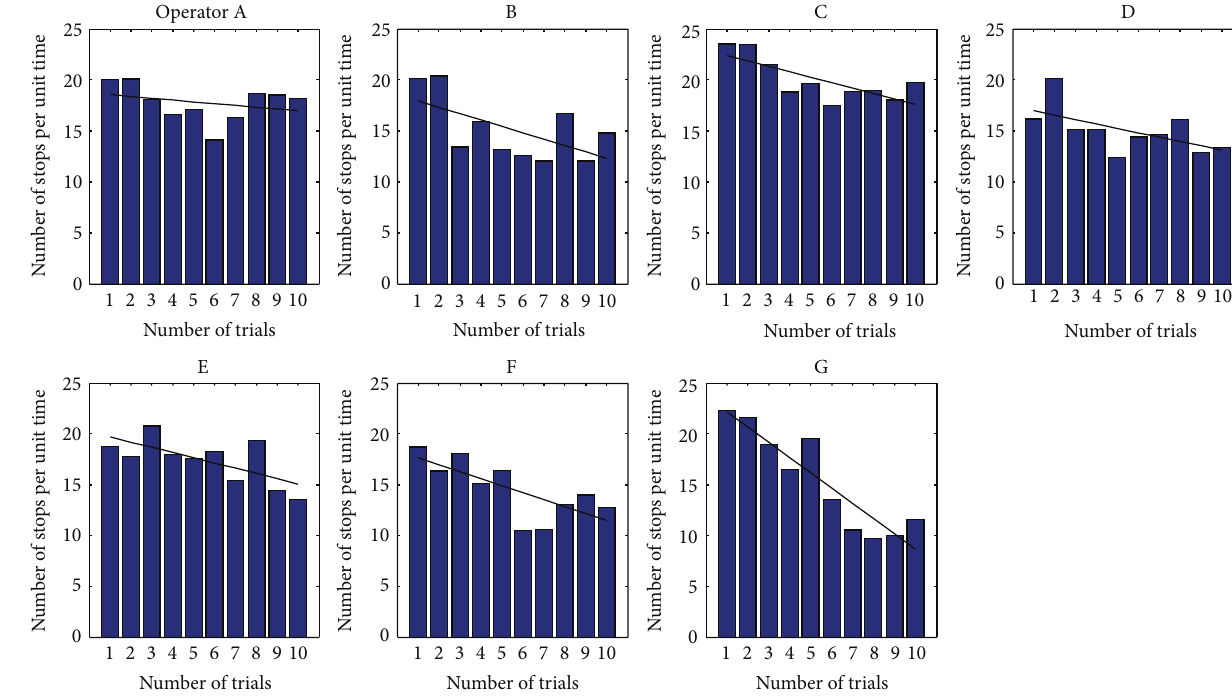
Figure 5: Transition of the frequency of pause for all operators ( P